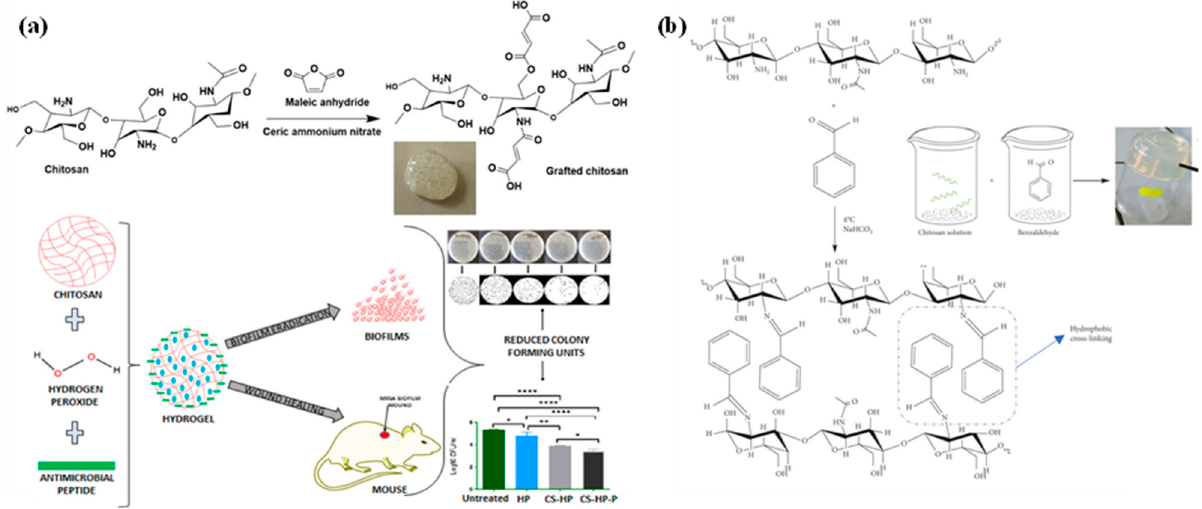
Figure 10. ( a ) Chitosan-based hydrogel preparation using maleic anhydride towards